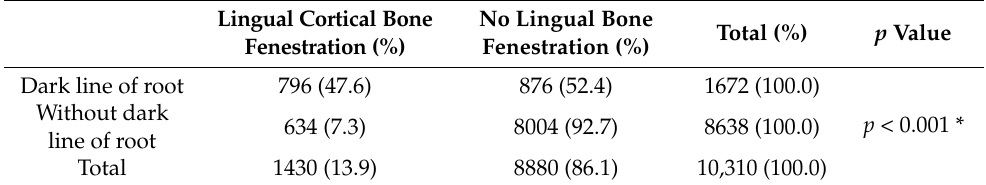
Table 8. Association between a dark line of root in panoramic view and lingual cortical bone fenestration in cone beam computed tomography